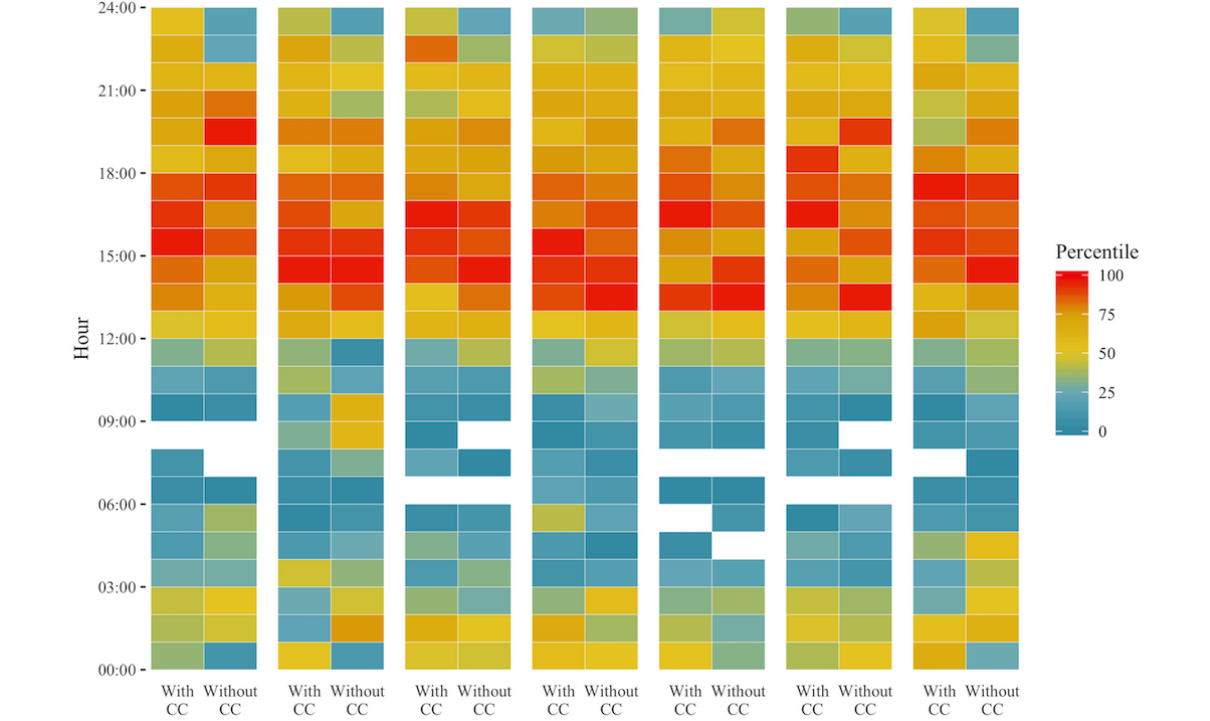
Figure 4. Time of communications by day, hour, and cohort for March 2016 to January 2017. Each week is separated by hours scored by percentile of conversations for that hour. The percentile of conversations (0 corresponding with 0 conversations for that hour) for persons with chronic conditions (With CC) and without chronic conditions (Without CC) are plotted for each hour in each day. The largest concentration of conversations for participants without chronic condition was on Mondays between 14:00-15:00, while it was on Sundays between 15:00-16:00 for persons with chronic conditions.